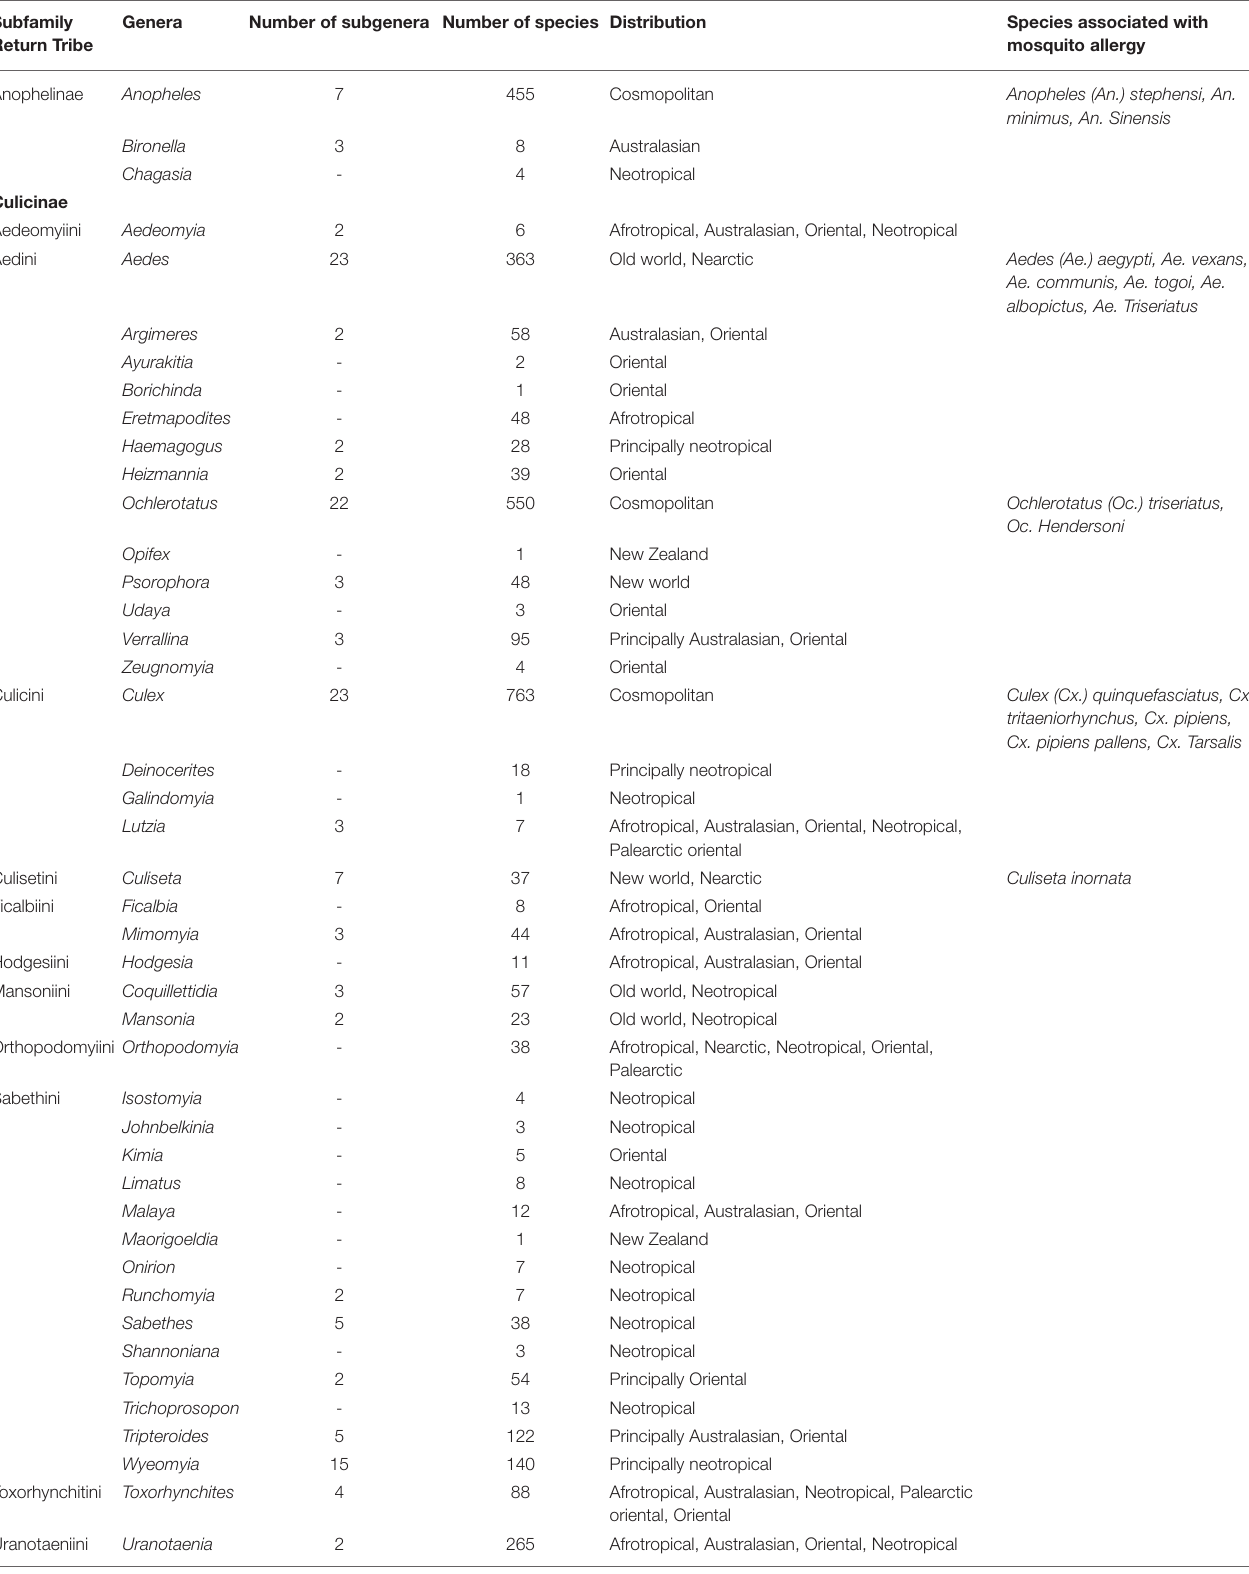
TABLE 1 | Taxonomical classification and distribution of the main mosquito species associated with mosquito allergy. Subfamily Number of subgenera Number of species Return Tribe